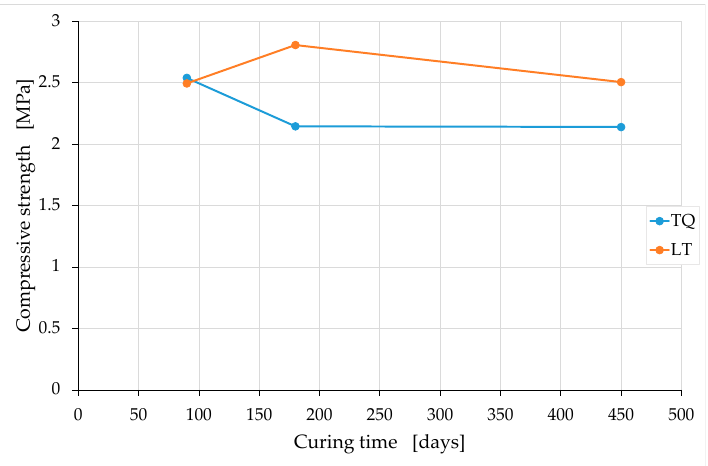
Figure 15. Trend over time of the average compressive strength values for the TQ and LT mixes.